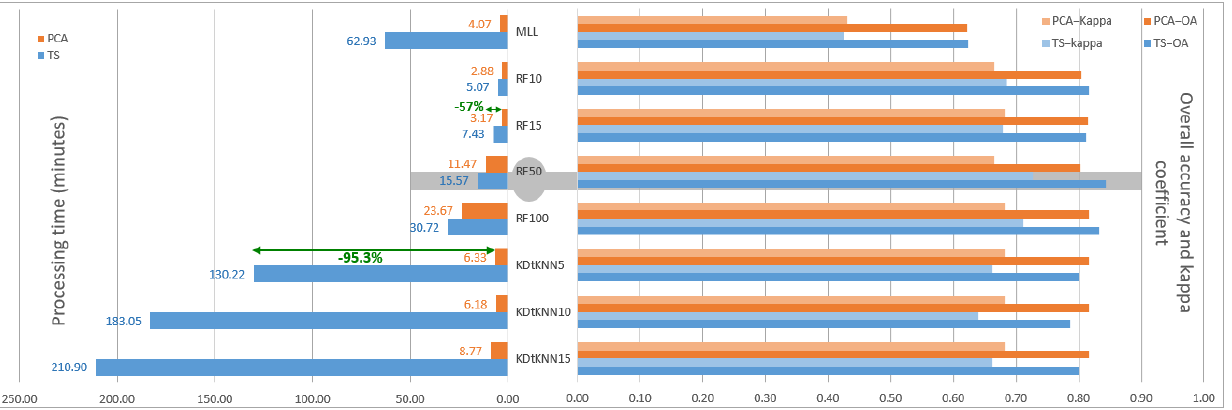
Figure 7. Comparison of different classifiers using overall accuracy (OA), kappa coefficient, and processing time. Note that the specifications of the computer used were quite high, namely Intel Core i7 10th generation 10,700 K, CPU 3.80 GHz, and 64 Go